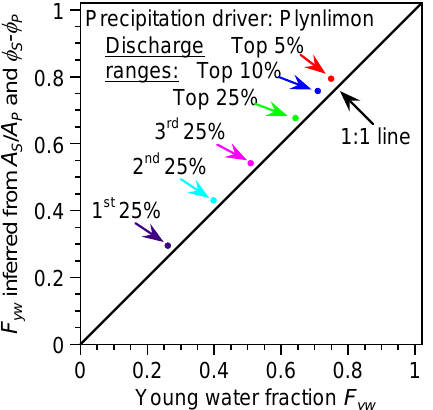
Figure 9. Time-averaged, flow-specific young water fractions F yw for the six discharge ranges shown in Fig. 8, measured by age track- ing in the model (with Plynlimon precipitation forcing and the ref- erence parameter set), compared to F yw values estimated from the amplitude ratios A S /A P and phase shifts ϕ S − ϕ P of the tracer cy- cles shown in Fig.